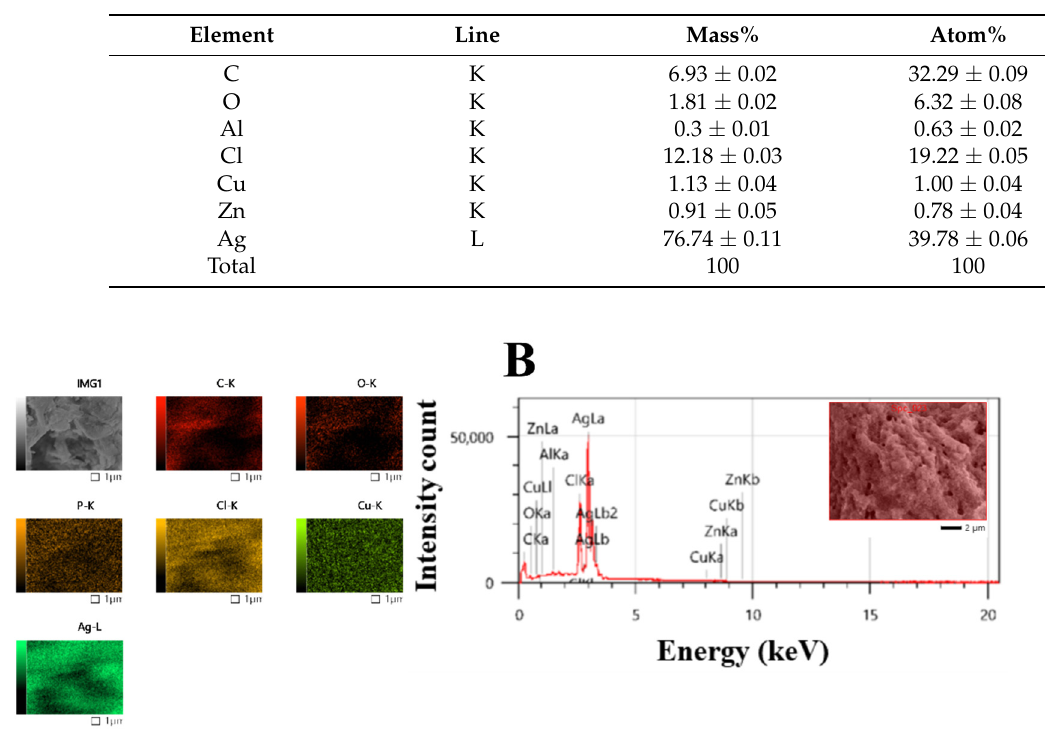
Table 2. EDx analysis of Uv@Ag-NPs synthesised from the unicellular ulvophyte sp. MBIC10591.